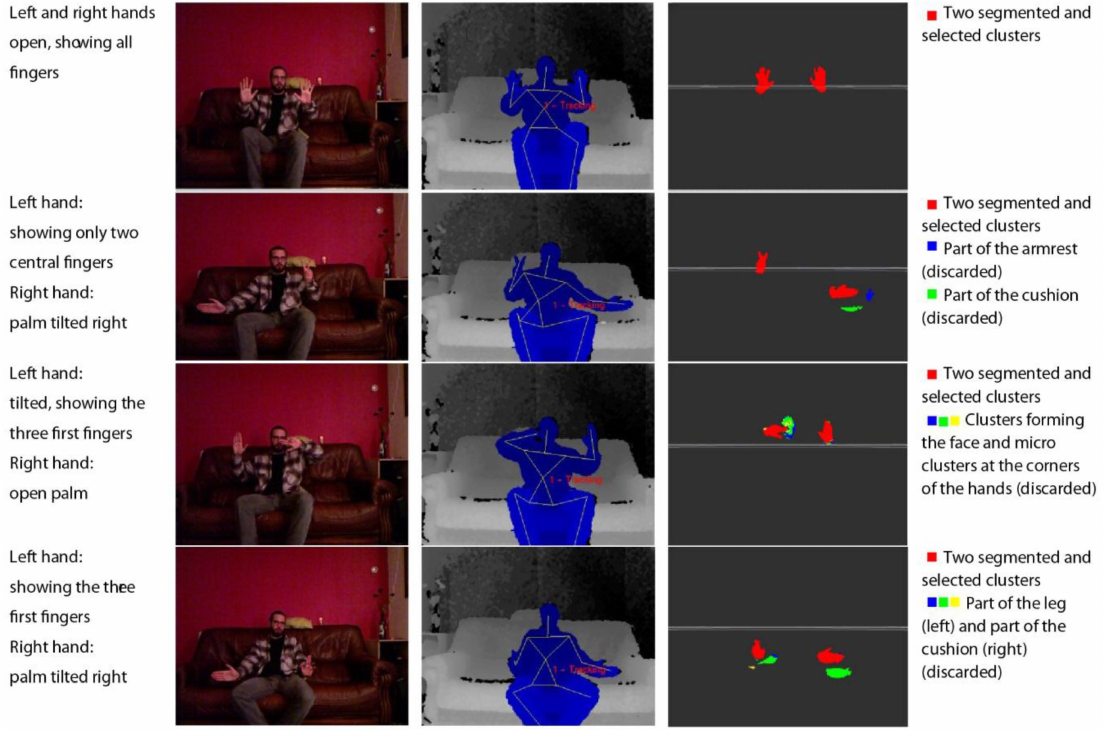
Figure 4. Representations of the detection of the human skeleton via the segmentation and filtering of a point cloud to detect the hands of a user sitting on a